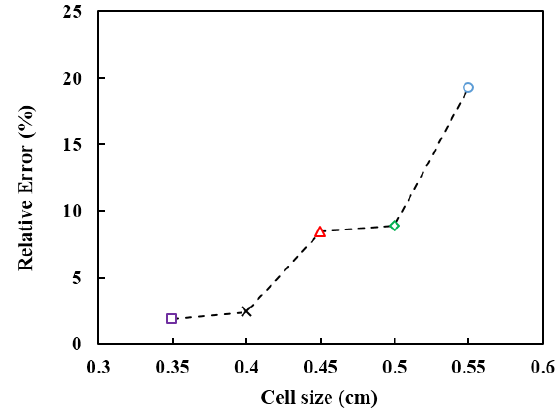
Figure 4. Variations of relative error of mean free-surface profiles versus cell size.